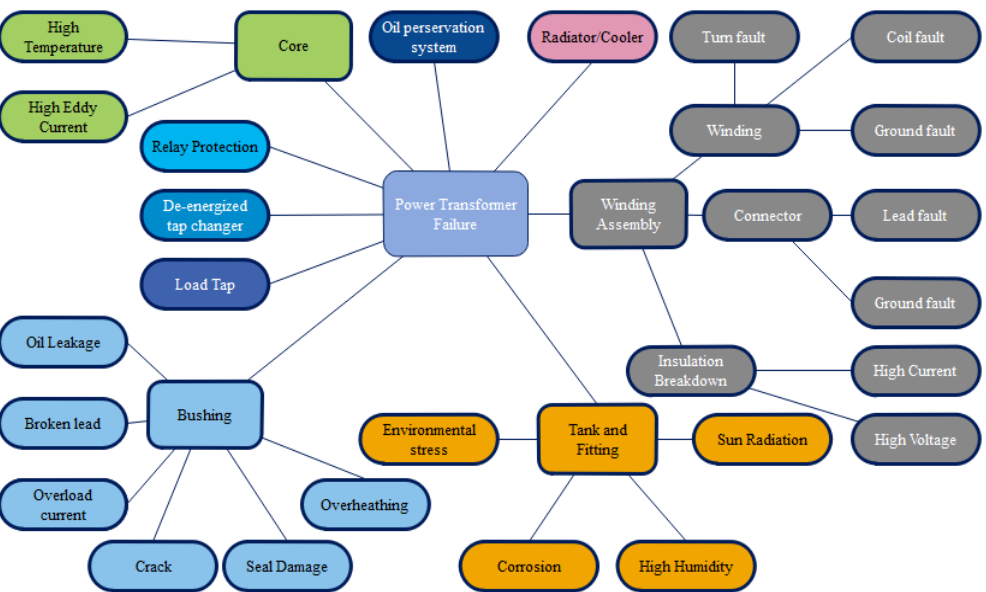
Figure 3. ISHIKAWA diagram of power transformer failures.